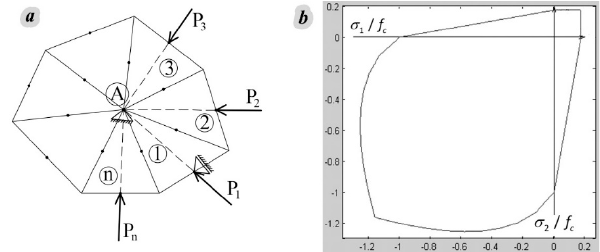
Figure 3. ( a ) Nodal zone polygon, ( b ) biaxial strength of concrete from the software “ST method.”.